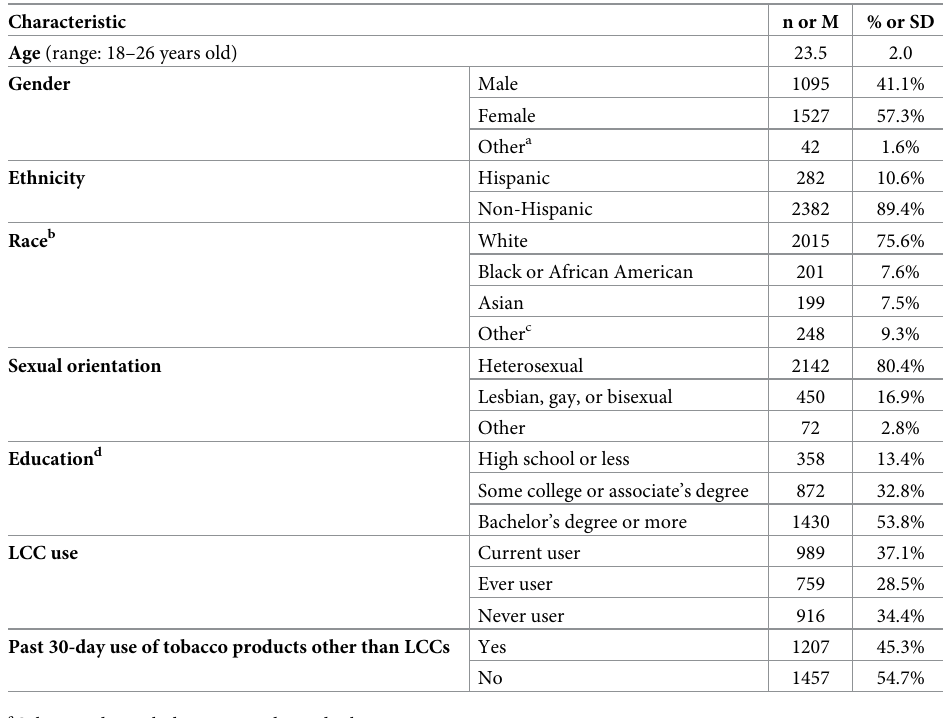
Table 2. Sample characteristics, n =